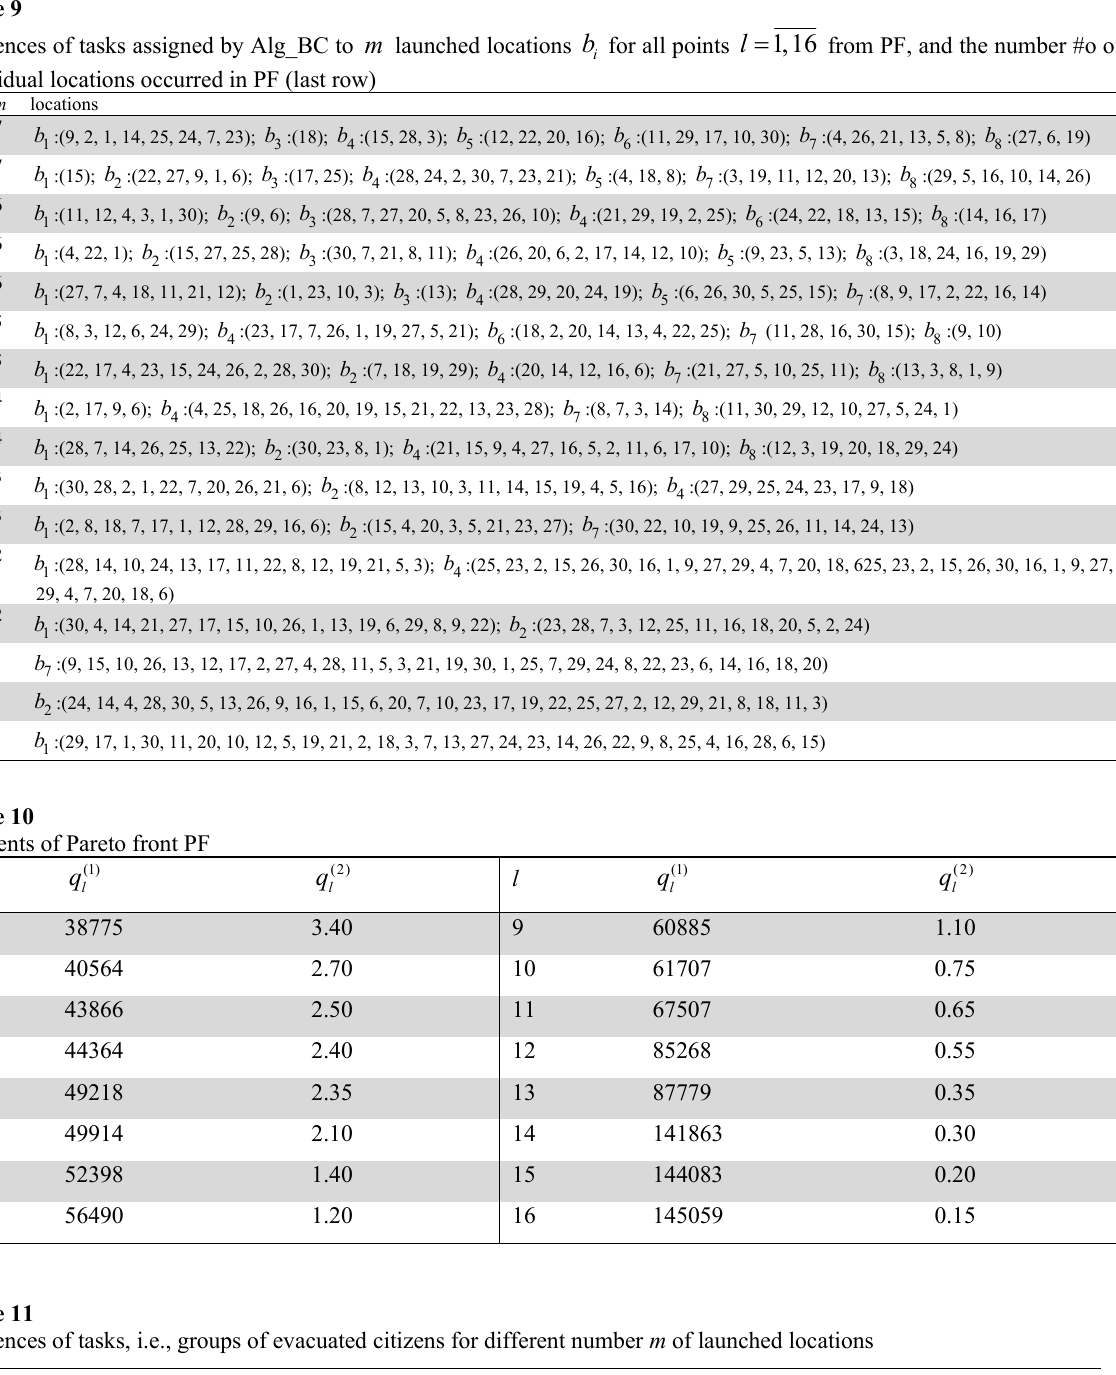
b for all points 1,16 l  from PF, and the number #o of i